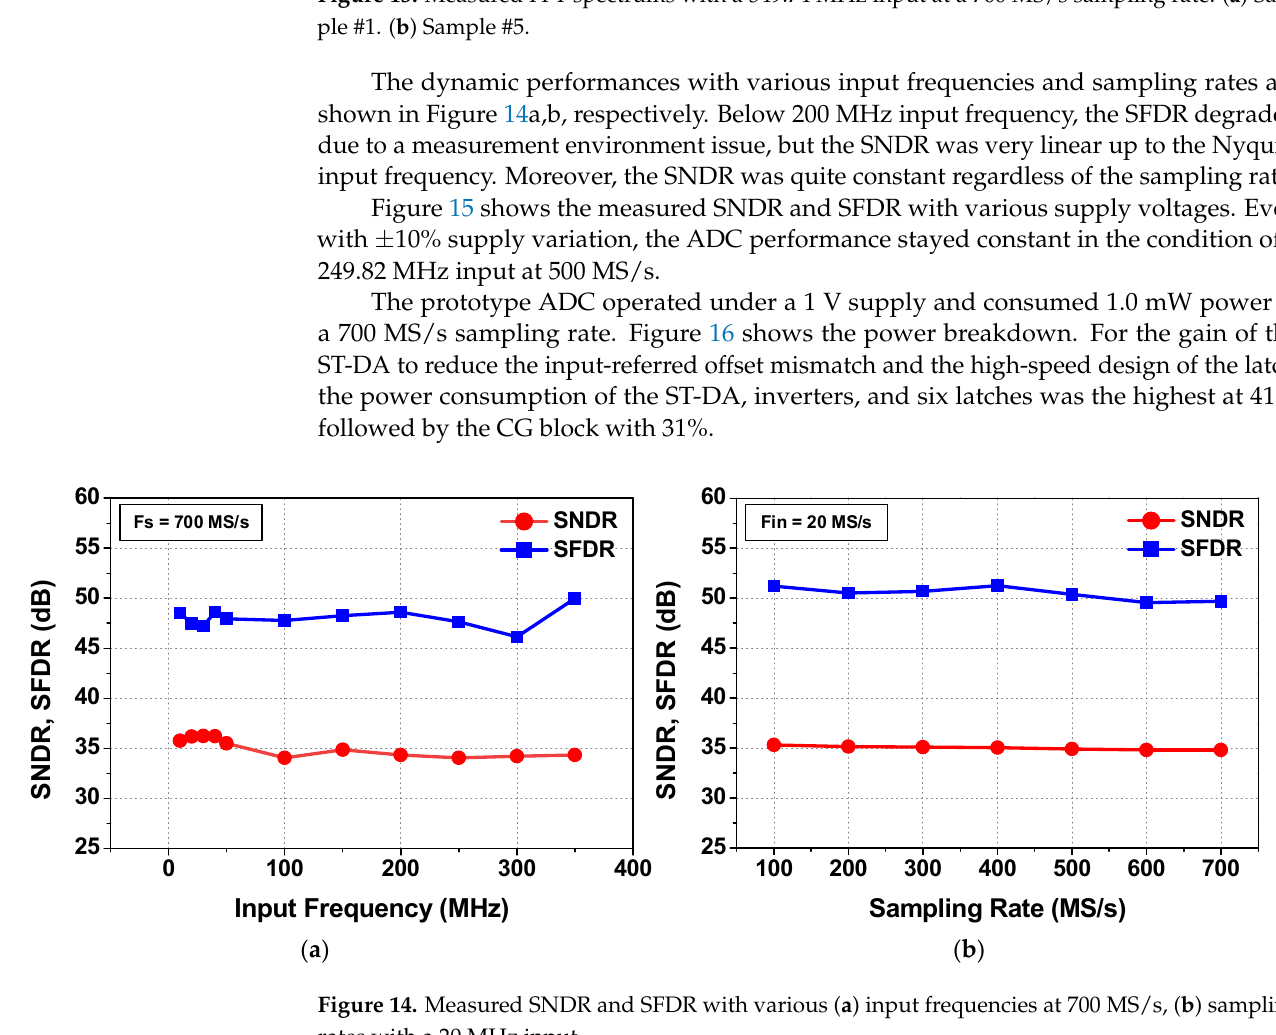
Figure 15. Measured SNDR and SFDR with various supply voltages within (cid:3399) 10%. Figure 16. Power breakdown.